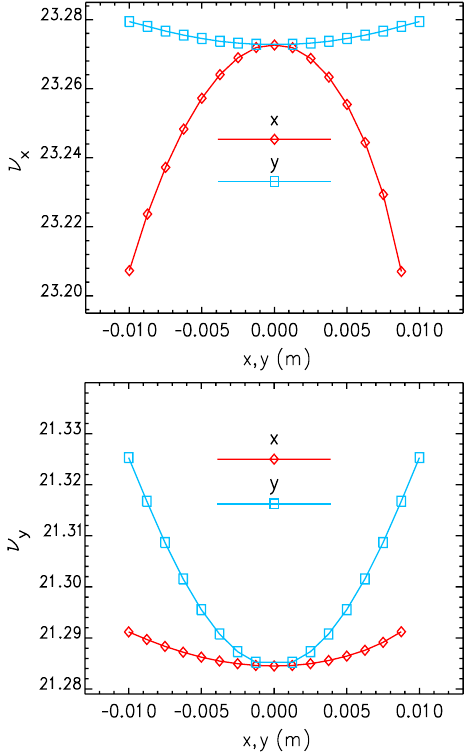
FIG. 15. Dependence of the horizontal (cid:8) x (top) and vertical (cid:8) y (bottom) betatron tunes on the initial transverse amplitudes x and y